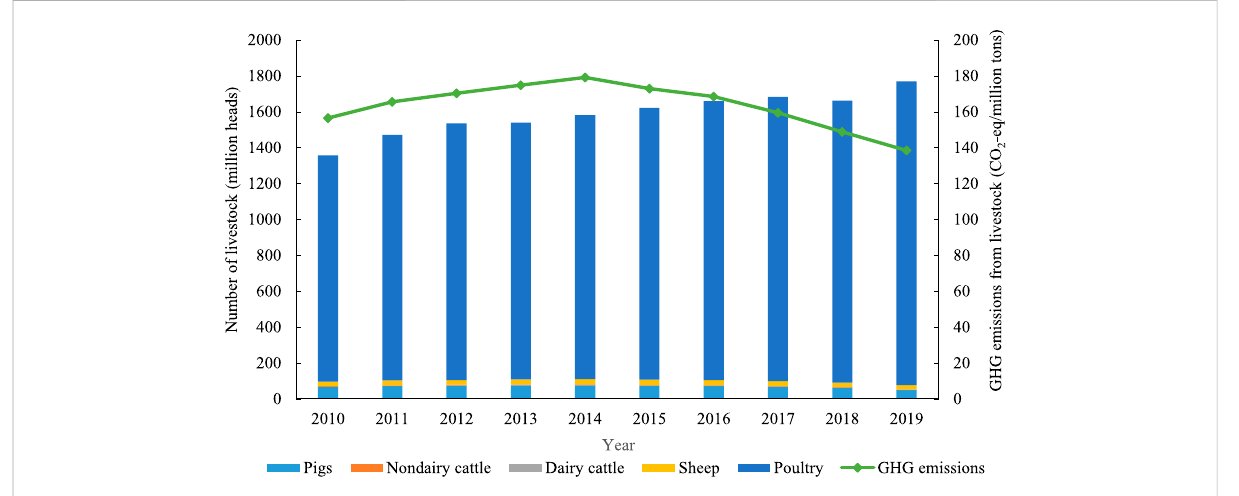
FIGURE 2 Number of livestock and GHG emissions from 2010 to 2019 in the CAGDMZ.